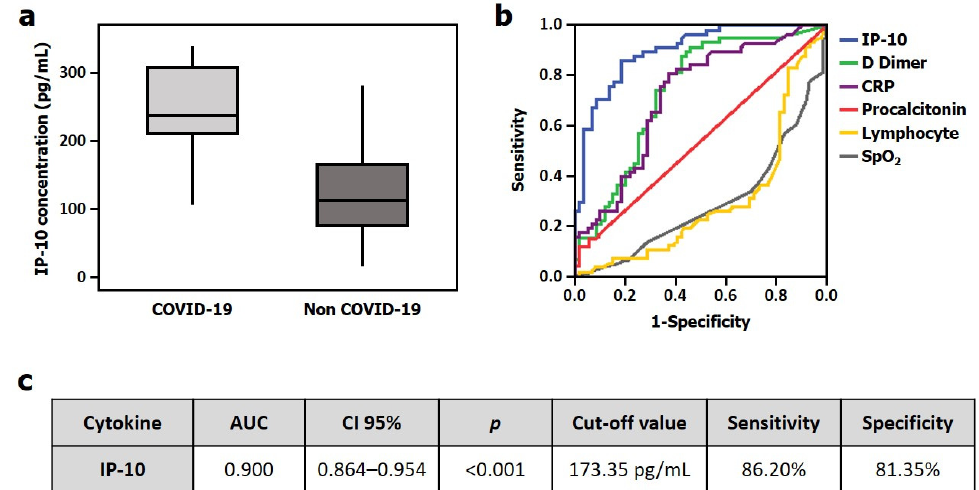
Figure 2. IP-10 in the validation cohort. ( a ) IP-10 plasma levels between COVID-19 and non-COVID-19 patients (Mann–Whitney U test). ( b ) Area under the ROC curve (AUC) analysis for evaluating the accuracy of different parameters for detecting COVID-19 infection. ( c ) Sensitivity and specificity calculation for IP-10 cut-off point.